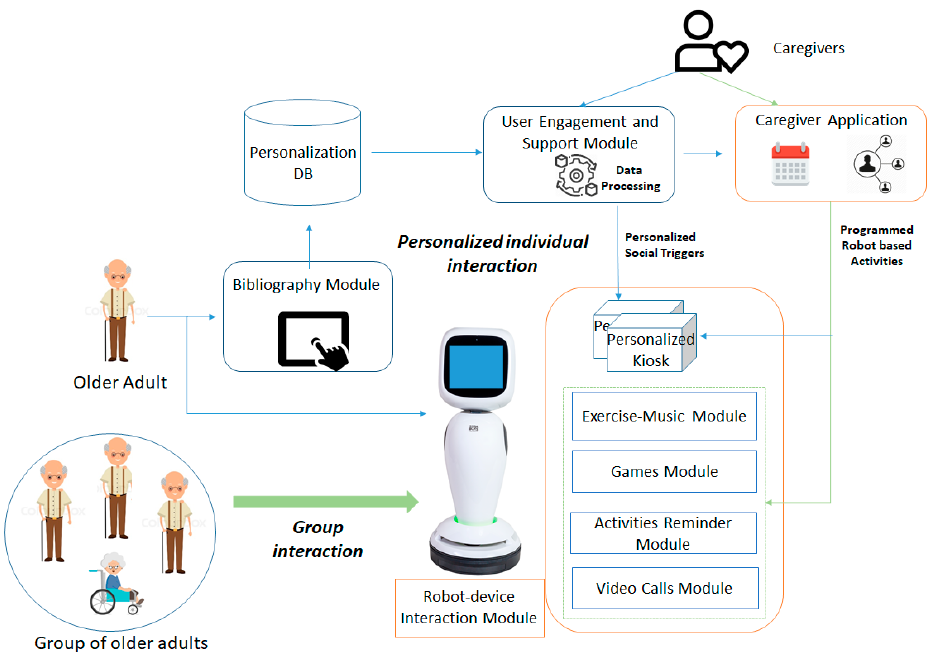
Figure 5. Personalization of the robot-based interaction.